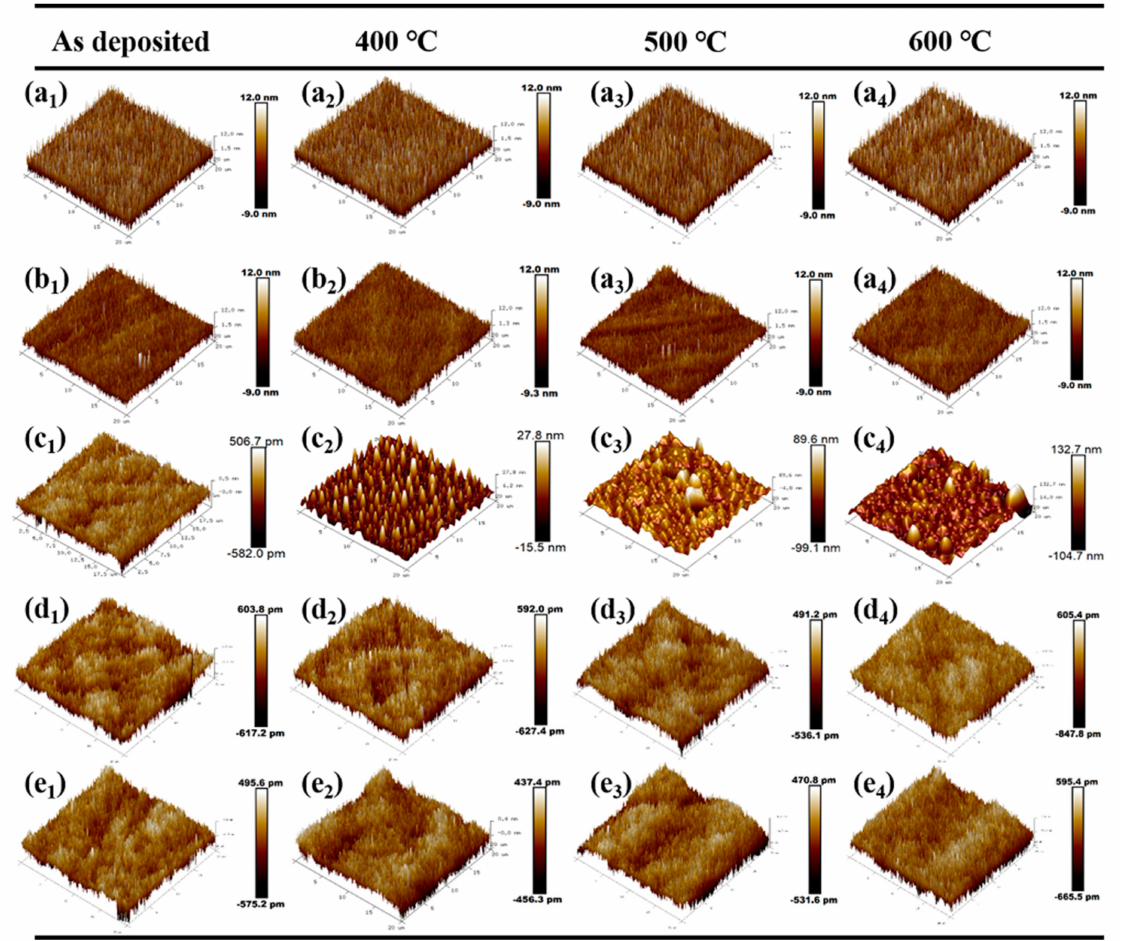
Figure 5. Surface morphologies of the Hf 1 − x SixO 2 nanocomposites annealed at different temperature. ( a 1 – a 4 ) Pure HfO 2 coatings, ( b 1 – b 4 ) Hf 0.90 Si 0.10 O 2 nanocomposites, ( c 1 – c 4 ) Hf 0.80 Si 0.20 O 2 nanocomposites, ( d 1 – d 4 ) Hf 0.70 Si 0.30 O 2 nanocom- posites; ( e 1 – e 4 ) Hf 0.60 Si 0.40 O 2